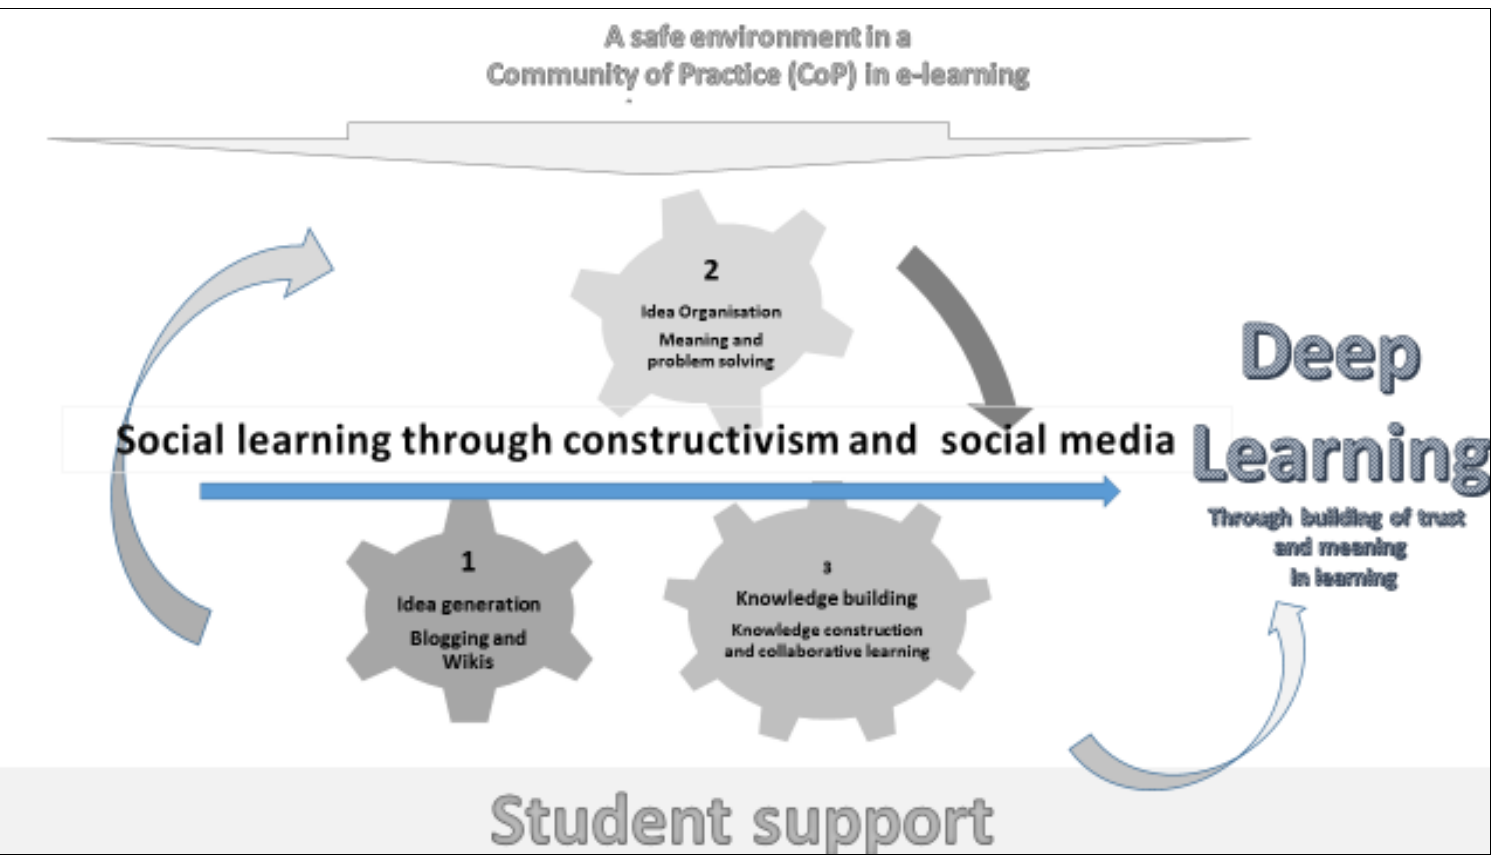
Figure 4 . The framework for using social media in e-learning (adapted from the OCL theory by Harasim,